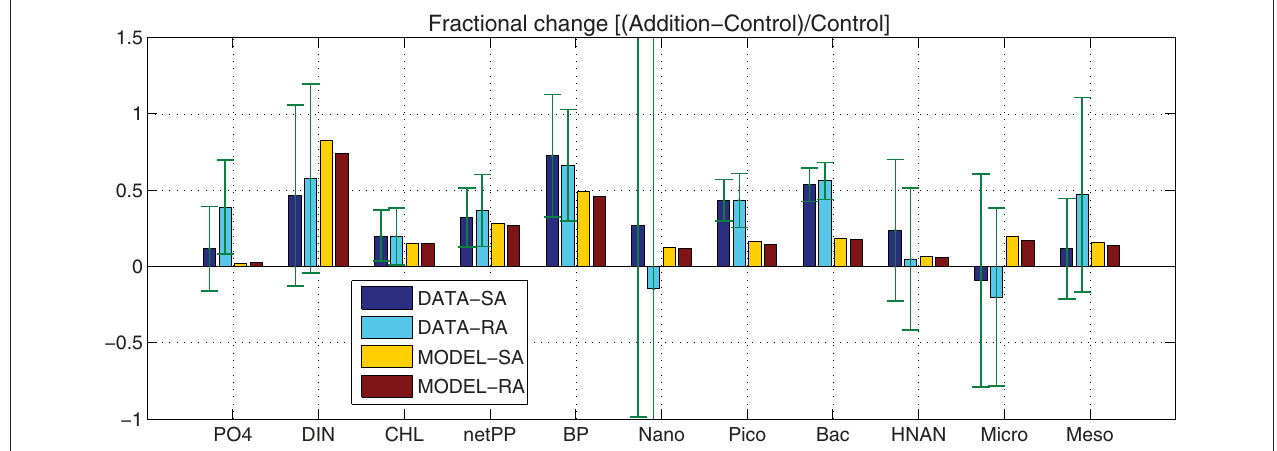
FIGURE 3 | Model simulated (MODEL-SA, MODEL-RA) and observed (DATA-SA, DATA-RA) mean fractional change [(Addition − Control)/Control] for phosphate, DIN, Chl-a, net primary production (netPP), bacterial production (BP), biomass of nanophytoplankton (Nano), picophytoplankton (Pico), bacteria (Bac), HNAN, microzooplankton (Micro), and mesozooplankton (Meso). The standard deviation in the observed fractional change is indicated. This was computed using the 10-day average of the mean ( µ ) and standard deviation ( σ ) from the three replicate measurements of the Addition (A) and Control (C) σ 2 µ 2) treatments as: σ (A/C 1) √ [ µ 2 A / µ 2 C * ( σ 2 A / µ 2 A C / C ] (Stuart and Ord, 1998). − ∼ +